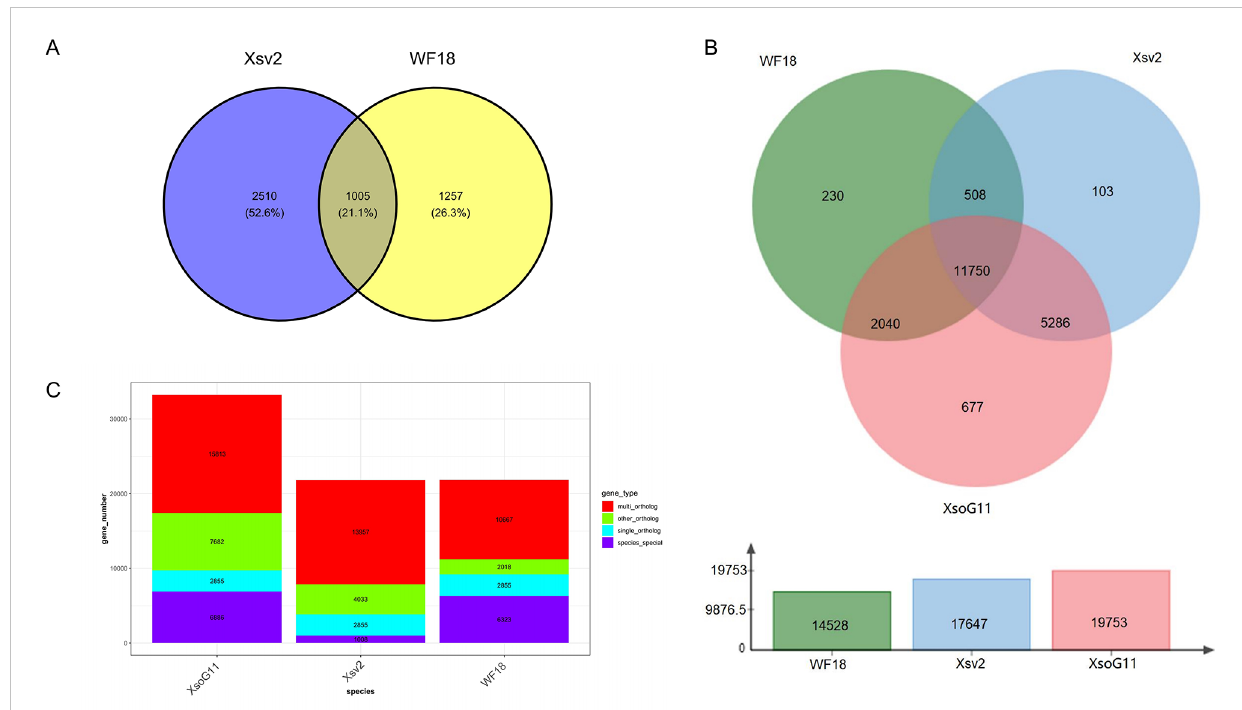
FIGURE 3 Pan-genome analysis of yellowhorn genomes. (A) The Venn diagram shows the number of SVs that are uniquely and commonly absent in the Xsv2 and WF18 genome, by comparing with the XsoG11 genome. (B) Pangenome-wide analysis of the core and dispensable gene families among three different yellowhorn genomes. (C) Gene family